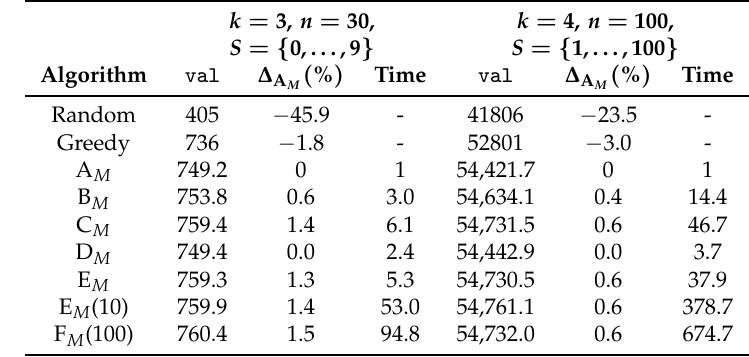
Table 2. The rows contain (respectively) the average values obtained by algorithms Random, Greedy, A m from [28], and by our Algorithms B m to C m over 1000 random complete 3-partite graphs, respectively. We can see that our Algorithms B m to F m outperform the algorithms from [28]. k = 3, n = 30, S = { 0, . . . ,9